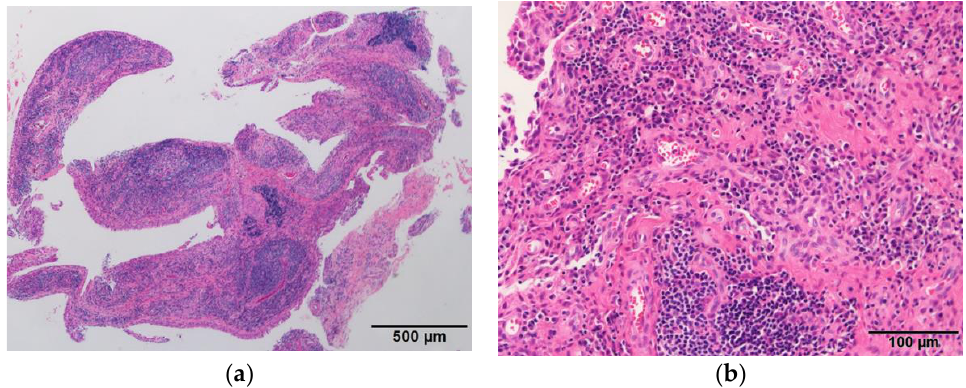
Figure 4. Surgical biopsy specimen of the subtalar joint region shows synovial proliferation and lymphocytes in the synovium ( a ). Proliferation of synovial lining cells, vascular proliferation, and lymphocyte infiltrate can be observed in the synovium ( b ).